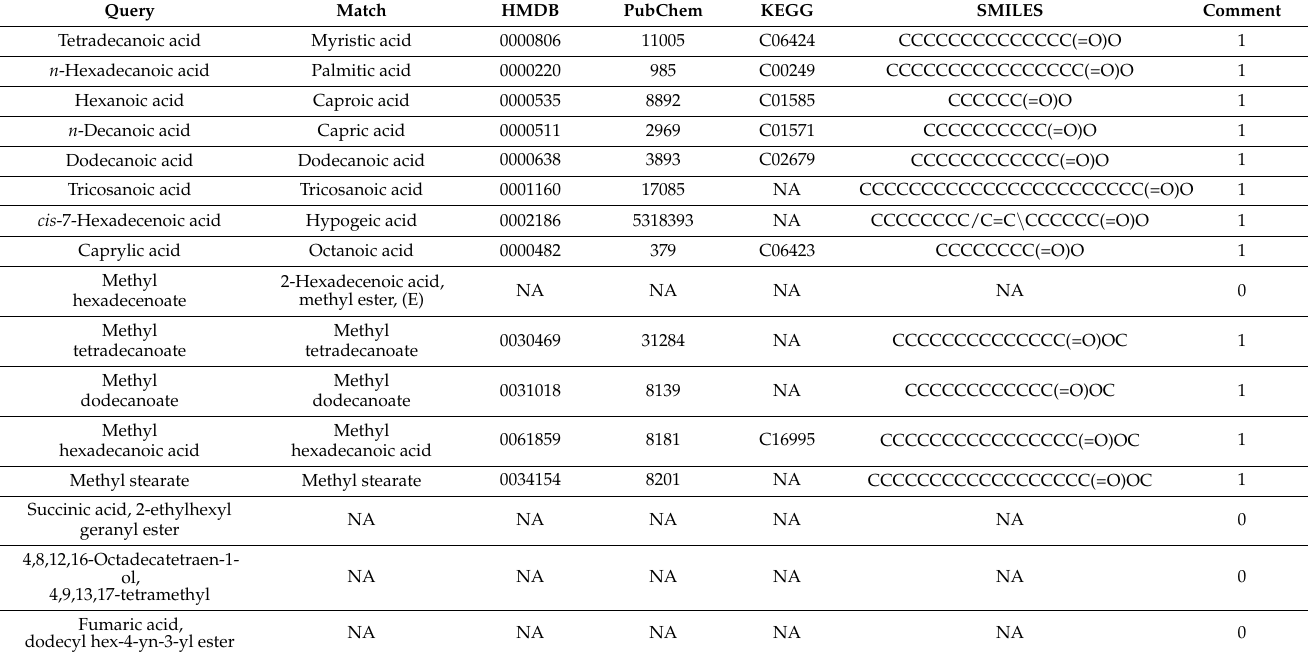
Table 2. Results of compound name mapping.